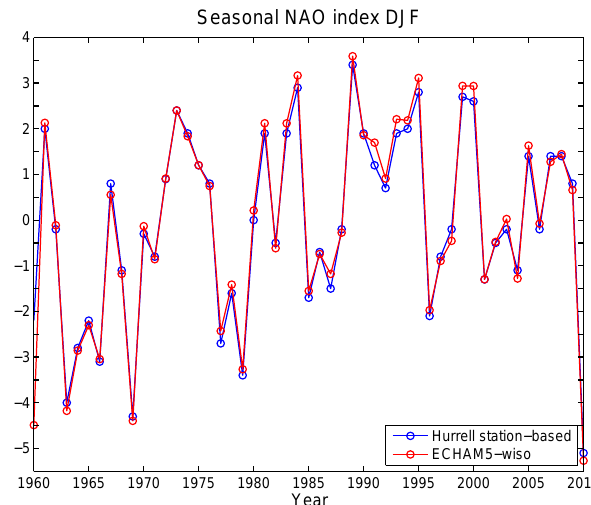
Figure 9. NAO winter (DJF) station index for the period 1960– 2010, according to observations (blue line; Hurrell et al., 2013), and as simulated by the ECHAM5-wiso model (red line).